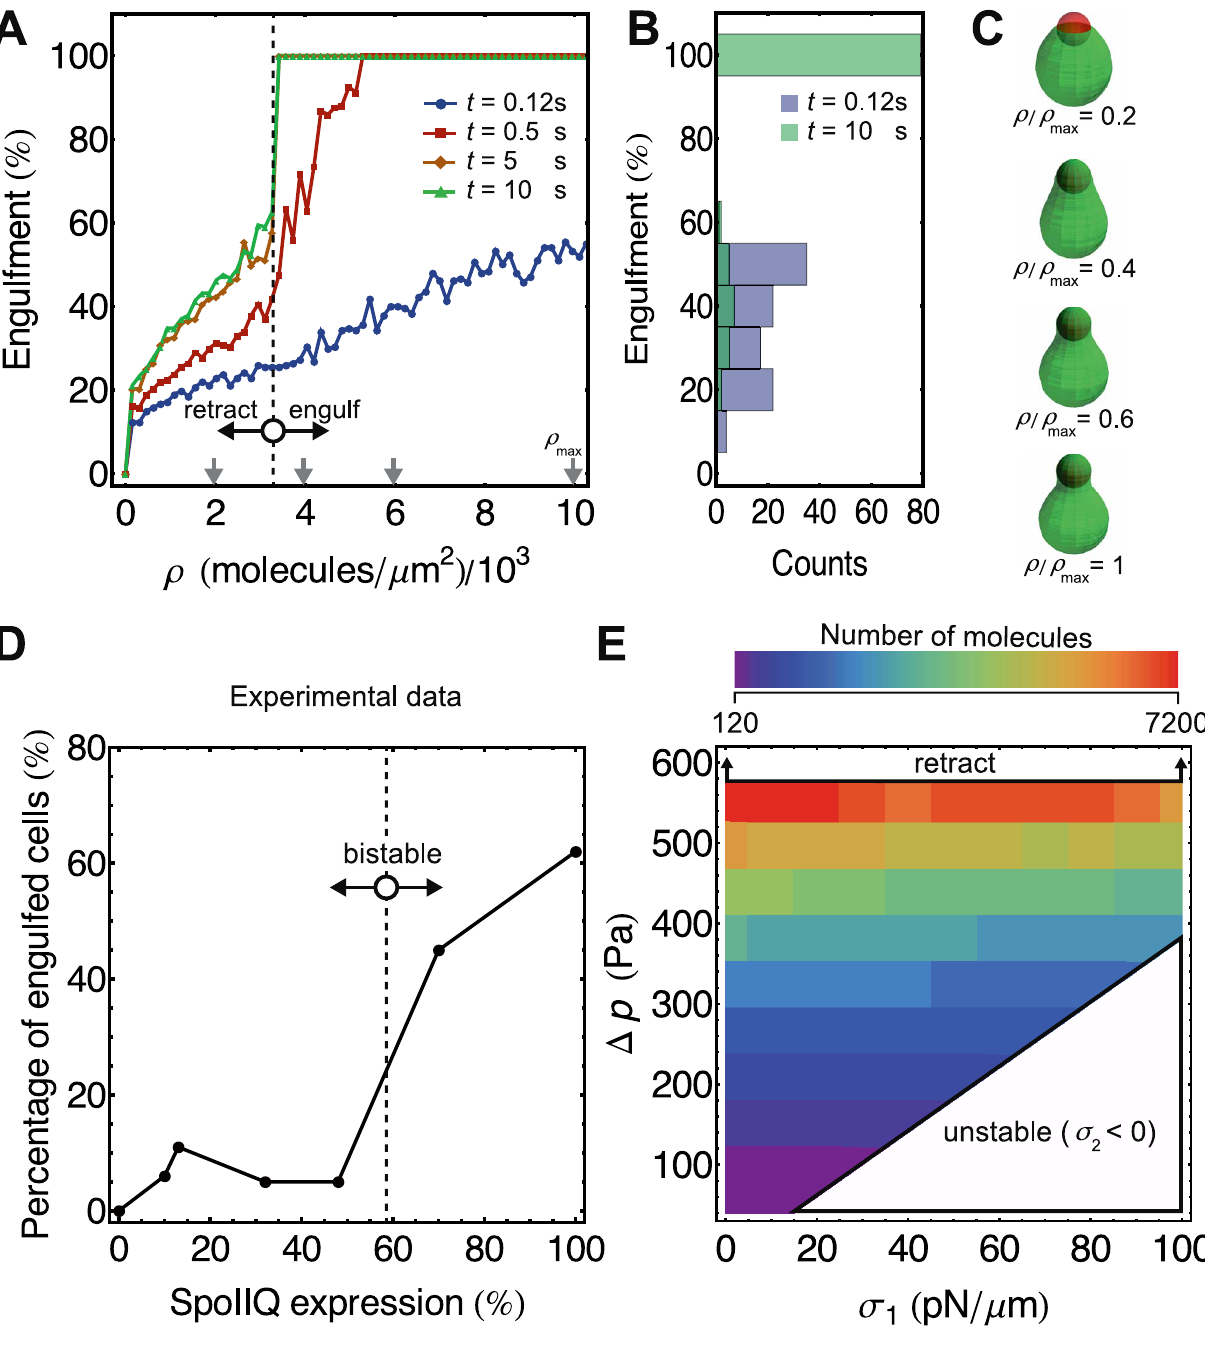
Figure 6. Bistable engulfment depends on zipper-molecule density. (A) Engulfment as a function of SpoIIQ protein surface density for s 1 =50 pN/ m m and D p =500 Pa. The total binding energy was converted to SpoIIQ protein-surface density using the binding energy of a single SpoIIQ- SpoIIIAH bond (see Text S1) [12]. Consistent with experimental results shown in (D) (extracted from [8]), engulfment is threshold-dependent on number of SpoIIQ proteins expressed in forespores. Gray vertical arrows point to surface densities for which snapshots are shown in (C) at 5 s. (B) Simulations lead to bistable outcome at later times ( t =10 s) with two subpopulations of stalled and fully completed cups. (E) For each set of constraint parameters ( s 1 and D p ) we performed a surface-density scan as in (A). The lower bound on the critical number of SpoIIQ molecules necessary for engulfment ranges from * 120 to * 7200 molecules depending on constraint parameters. differences ( D p ). For example, for a given SpoIIQ surface density, osmolarity of the suspended buffer. Decreased osmolarity indeed caused mother-cell swelling and stopped engulfment in line with high surface tension restricts the engulfment region while high osmotic pressure prevents engulfment. To test this prediction we our predictions (Fig. 7). Another prediction, such as the need for increased the osmotic pressure difference by lowering the an excess of mother-cell membrane, might be tested by controlling